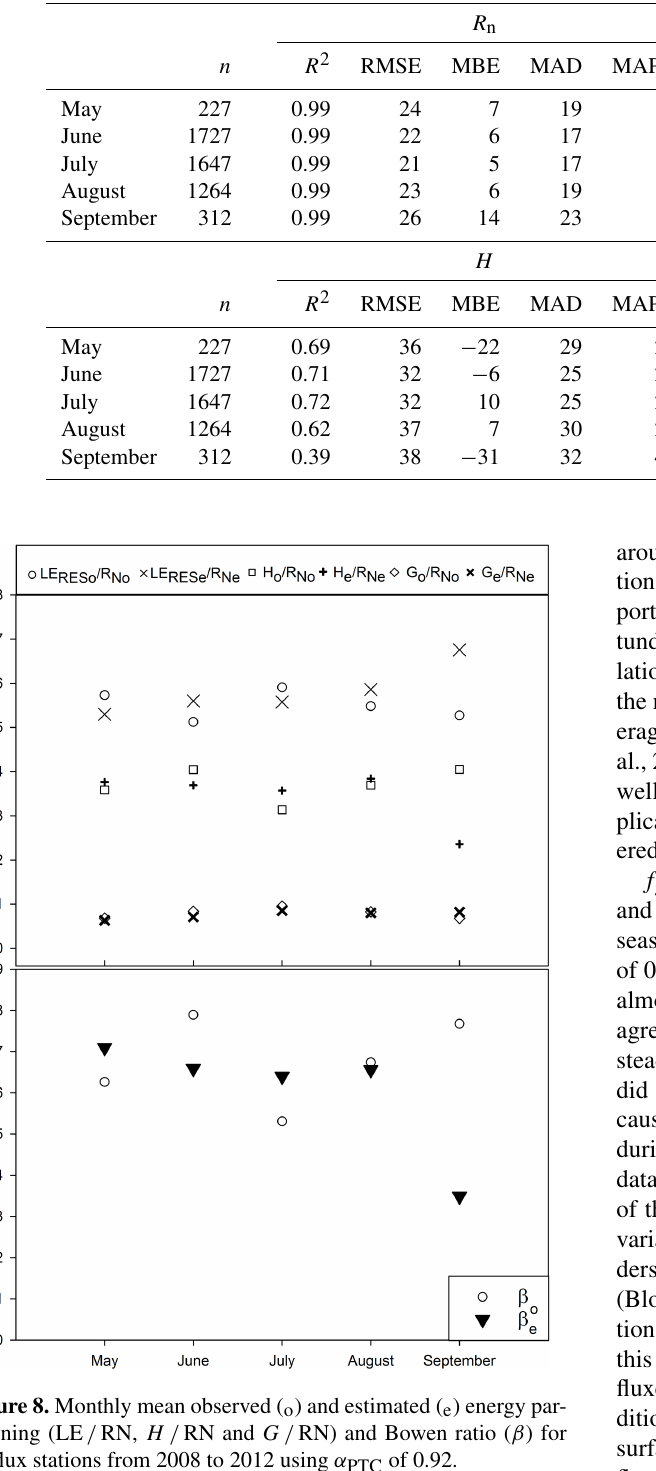
Table 7. Mean monthly accuracy and error statistics from the comparison of modeled vs. observed surface fluxes (using LE from residual